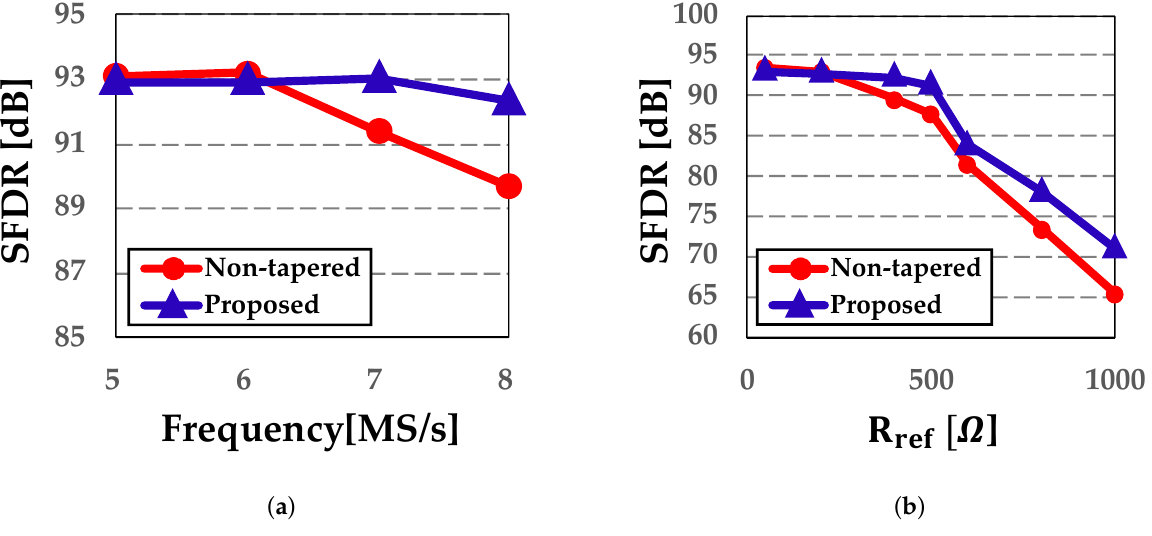
Figure 14. The 12-bit ADC SFDR performance according to ( a ) sampling frequency when R ref = 400 Ω , ( b ) impedance of the R ref at 8